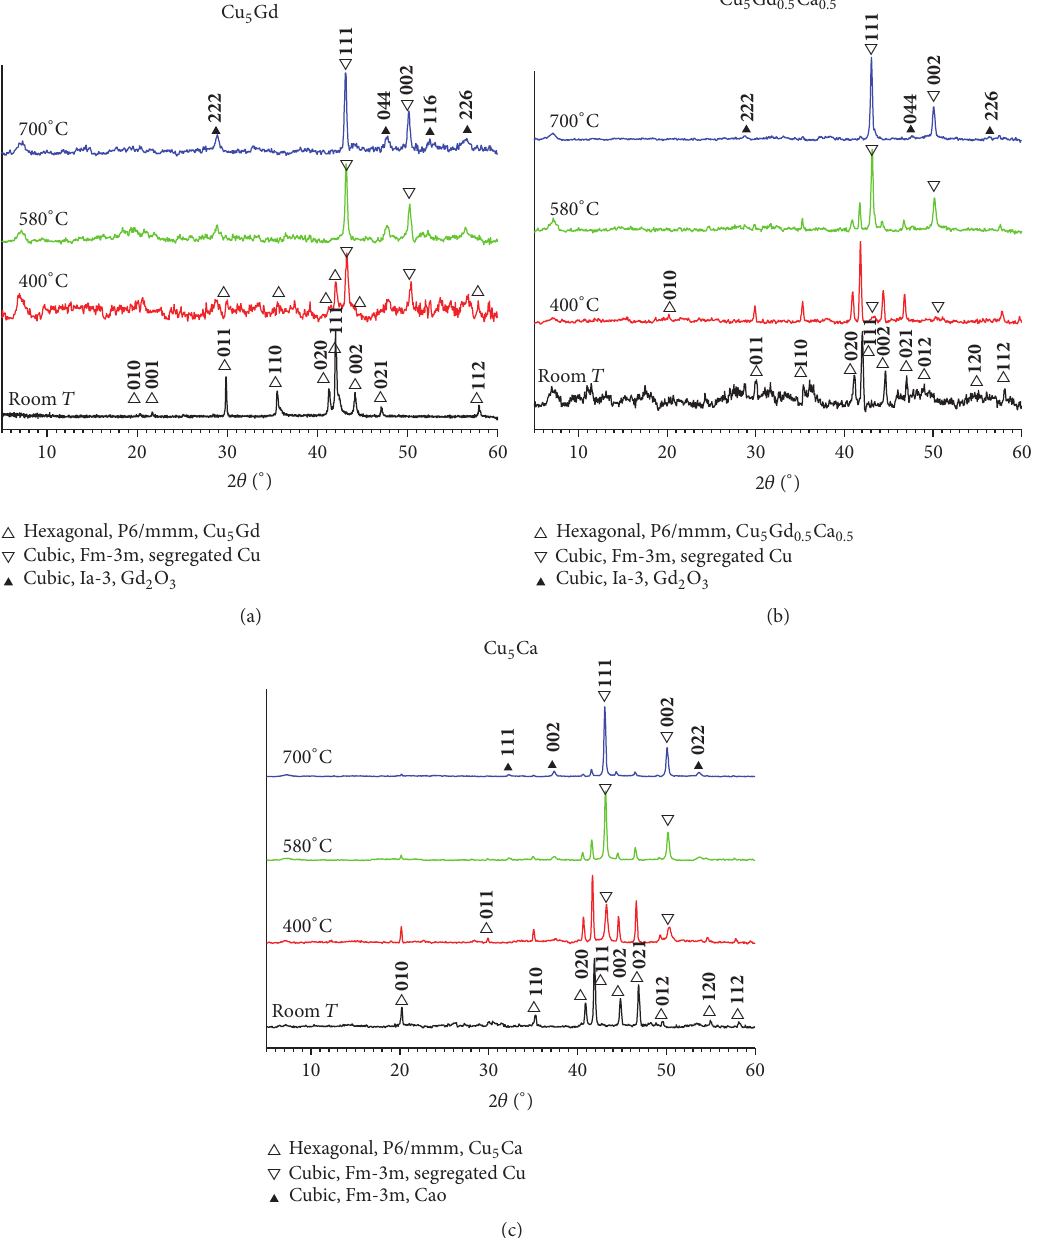
electron gas. Therefore, no information about the